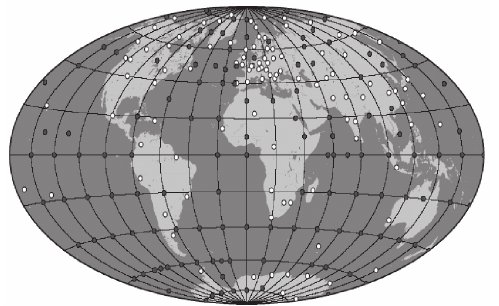
Fig. 9. Real and virtual Observatory locations (Hammer Projection)